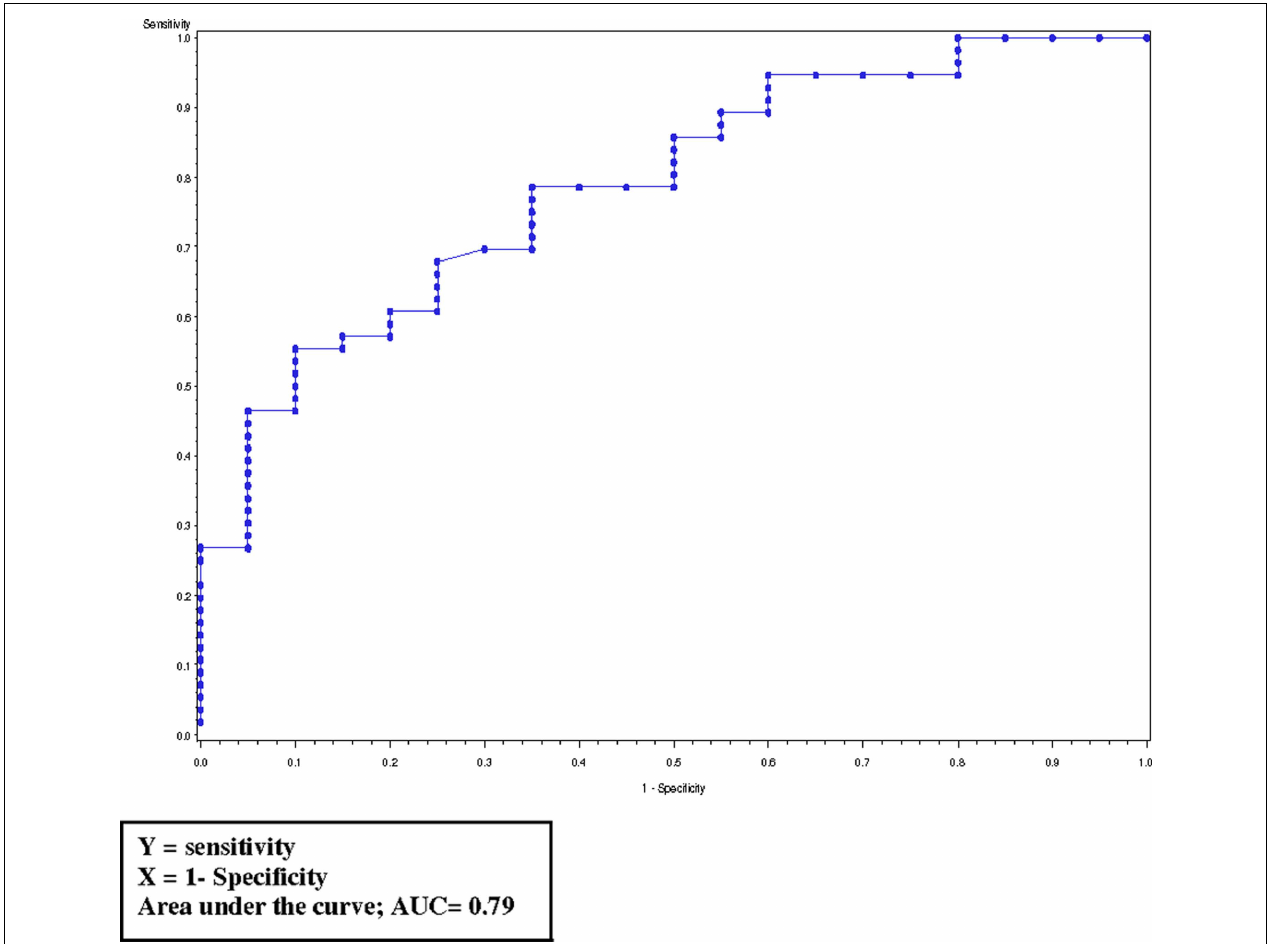
FIGUREA1 | Receiver operating characteristic curve for log